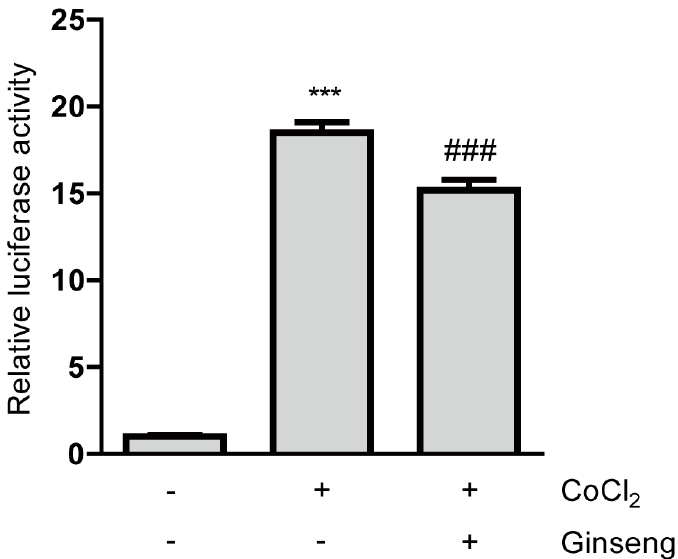
Figure A1. An inhibitory e ff ect of panax ginseng on HIF activity. Quantitative analysis of HIF-reporter luciferase assay using ARPE-19 cells ( n = 3 per group) showed that ginseng inhibited CoCl 2 -induced HIF activity. *** p < 0.001, ### p < 0.001, compared with no treatment and 200 µ M of CoCl 2 treatment, respectively. A bar graph was presented as mean ± standard deviation. The data were analyzed using one-way ANOVA followed by a Bonferroni post hoc test. Solvent, ginseng: water.